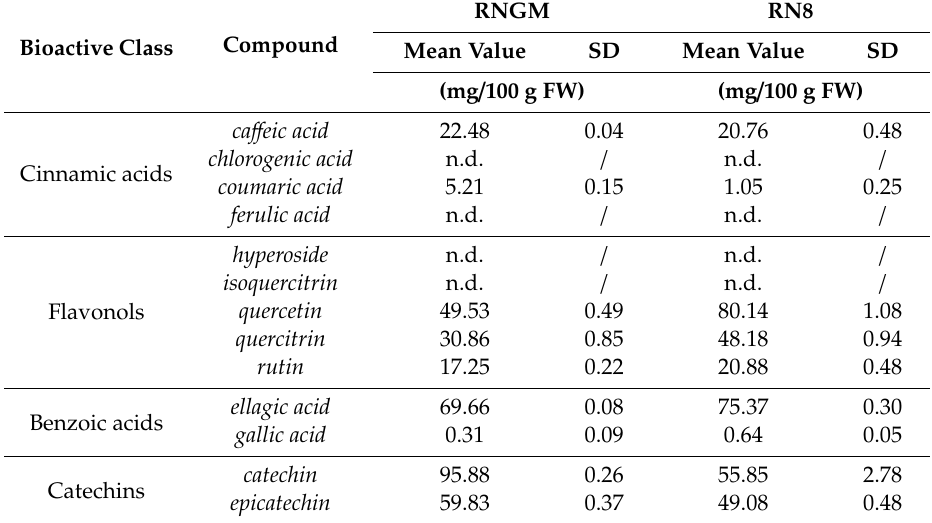
Table 3. Targeted phytochemical fingerprint by HPLC-DAD of the polyphenolic compounds in the most promising R. nigrum extract (RN8) obtained by PUAE compared to the corresponding glyceric macerate